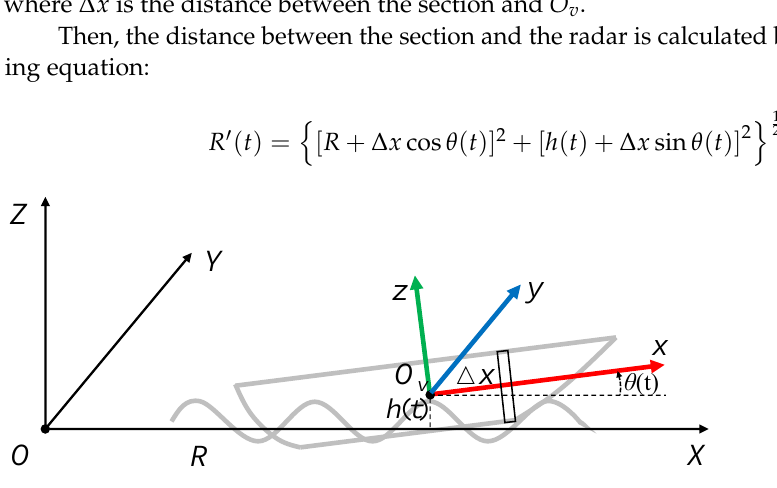
Figure 1. The coordinate systems of the